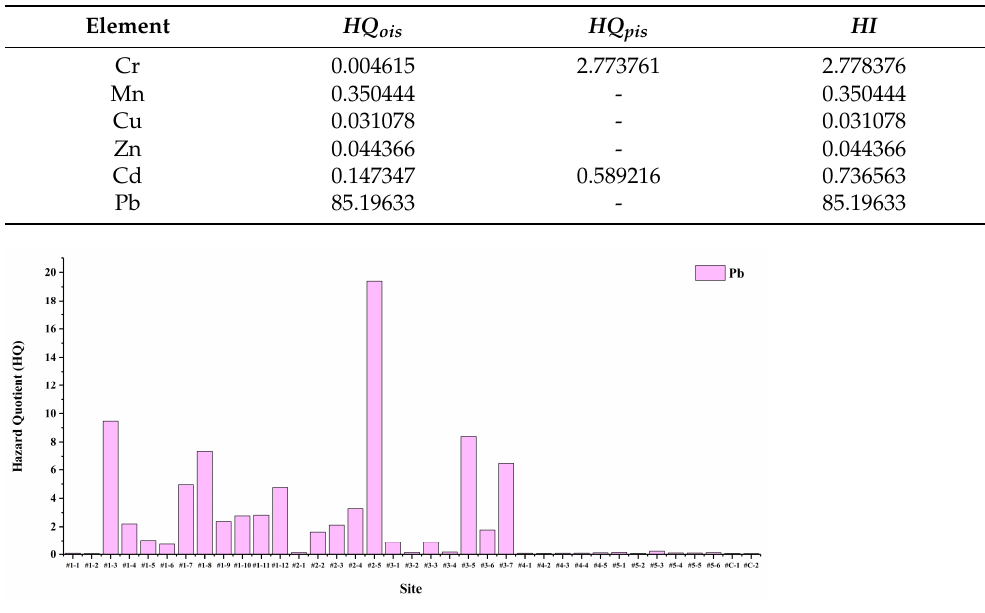
Figure 7. Distribution of HQ ois values of Pb in the surface soil of each sample site.